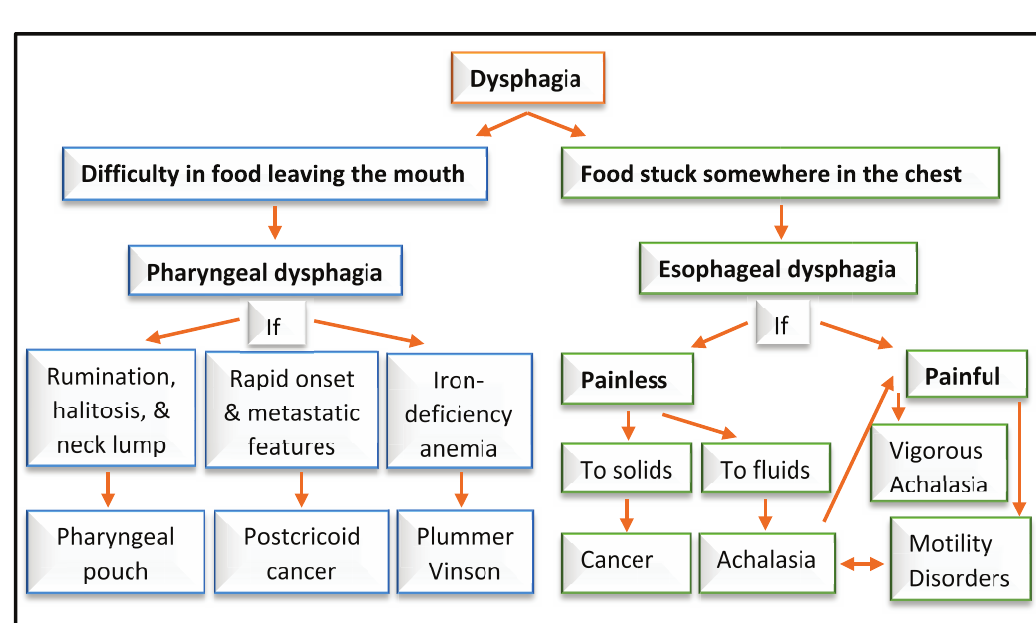
Figure 1: Teaching from presentation to diagnosis (also an example of a concept